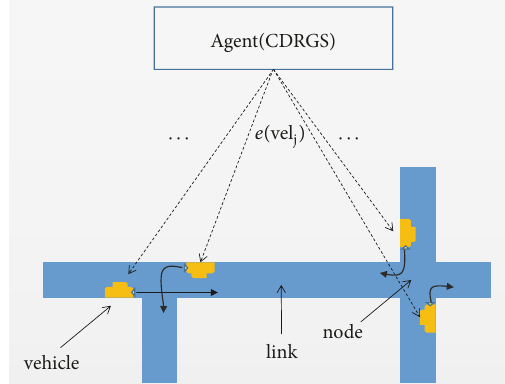
Figure 4: Demonstration of vehicle guidance in the